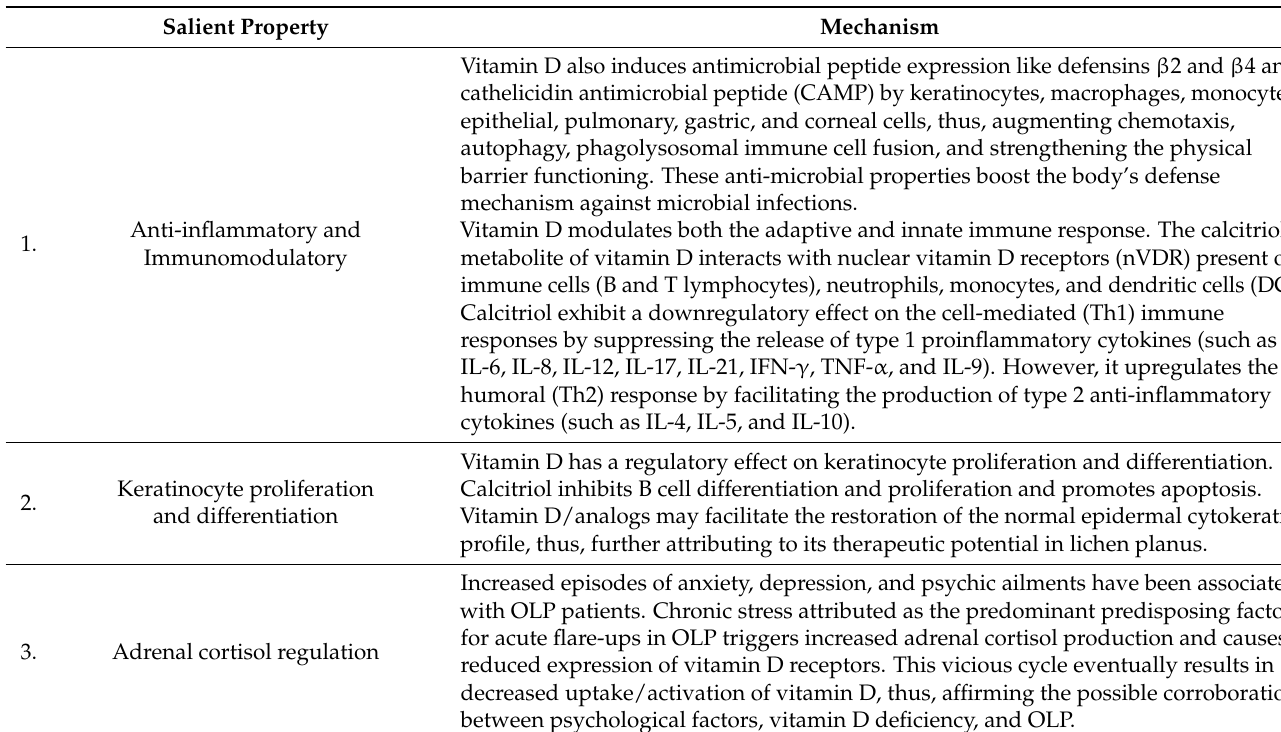
Table 2. Workflow of vitamin D in Oral Lichen